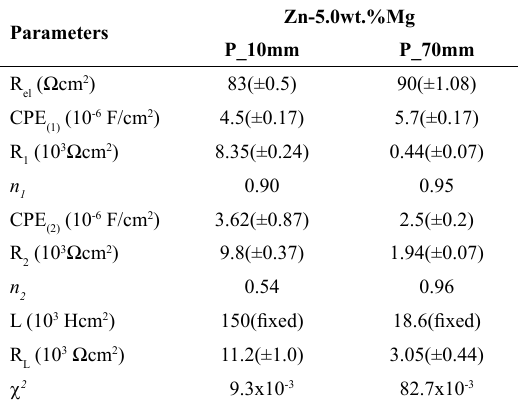
Table 2. Results of the simulated impedance parameters for the P_10mm and P_70mm of the Zn-5.0wt.%Mg alloy